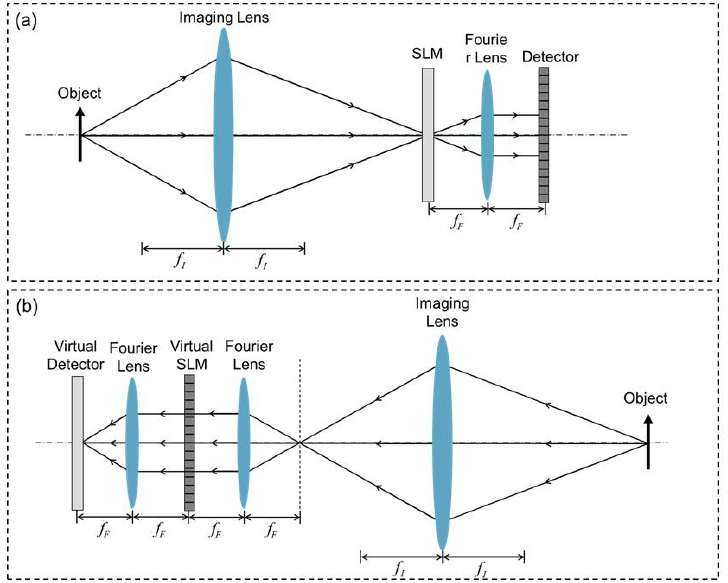
Figure 3. The imaging configuration of Fourier dual photography: ( a ) the primal configuration; ( b ) the dual